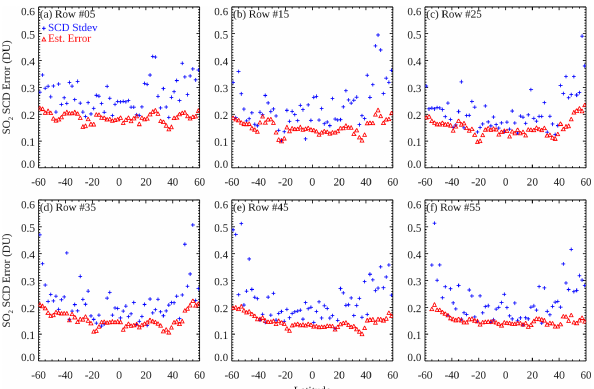
Figure 3. Mean SO 2 SCD uncertainties estimated from fitting resid- uals ( ε SCD , red triangles) and SCD standard deviation ( σ SCD , blue plus signs) for 2 ◦ latitude segments between 60 ◦ S and 60 ◦ N from selected OMI rows from orbit 14456 on 3 April 2007.